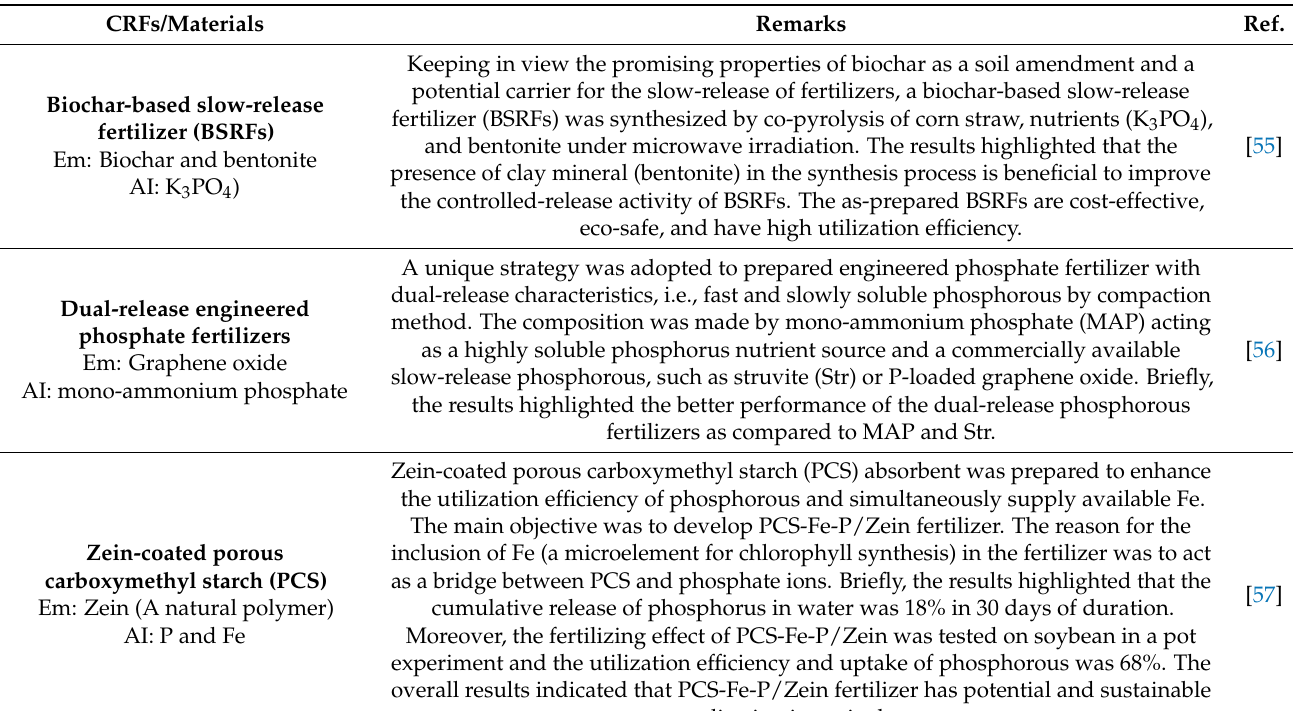
Table 2. Recent innovations related to CRFs/materials. Encapsulating material: